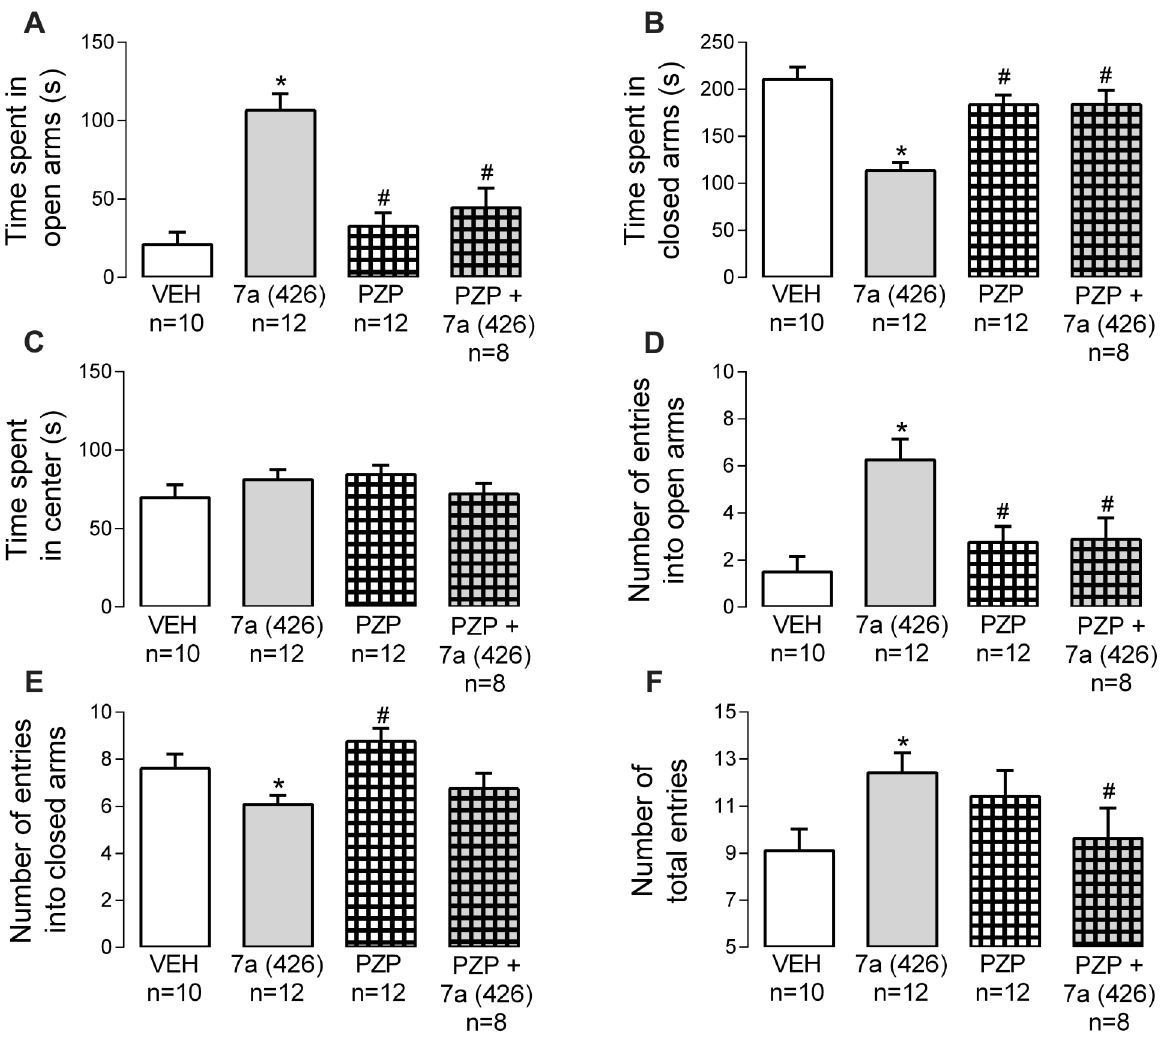
Figure 3. Contribution of muscarinic receptor subtype 1 (as revealed by the antagonism with pirenzepine) to the anxiety-like effect evoked by Bj-PRO-7a in the elevated plus maze. A , Time spent in open arms; B , Time spent in closed arms; C , Time spent in center; D , Number of entries into open arms; E , Number of entries into closed arms; F , Number of total entries. Experimental groups: VEH: vehicle (0.9% NaCl); 7a (426): Bj-PRO-7a (426 nmol/kg); PZP: pirenzepine (852 nmol/kg); PZP + 7a (426): co-administration of pirenzepine and Bj-PRO-7a (426 nmol/kg). Data are reported as means ± SE. *P o 0.05 vs vehicle; # P o 0.05 vs 7a (426) (one-way analysis of variance followed by Fisher ’ s post hoc